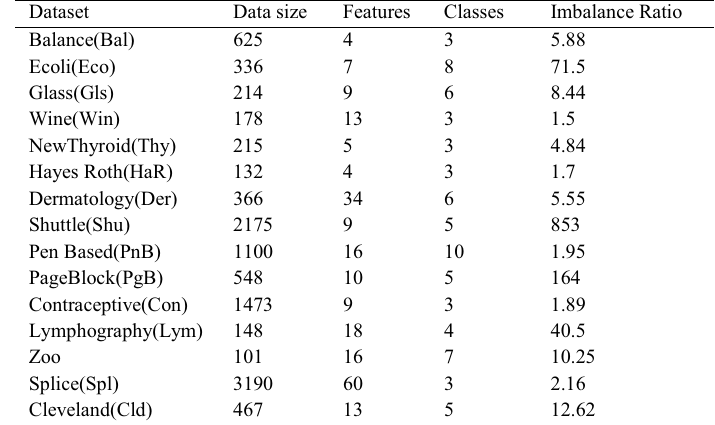
Table 1. Details of benchmark